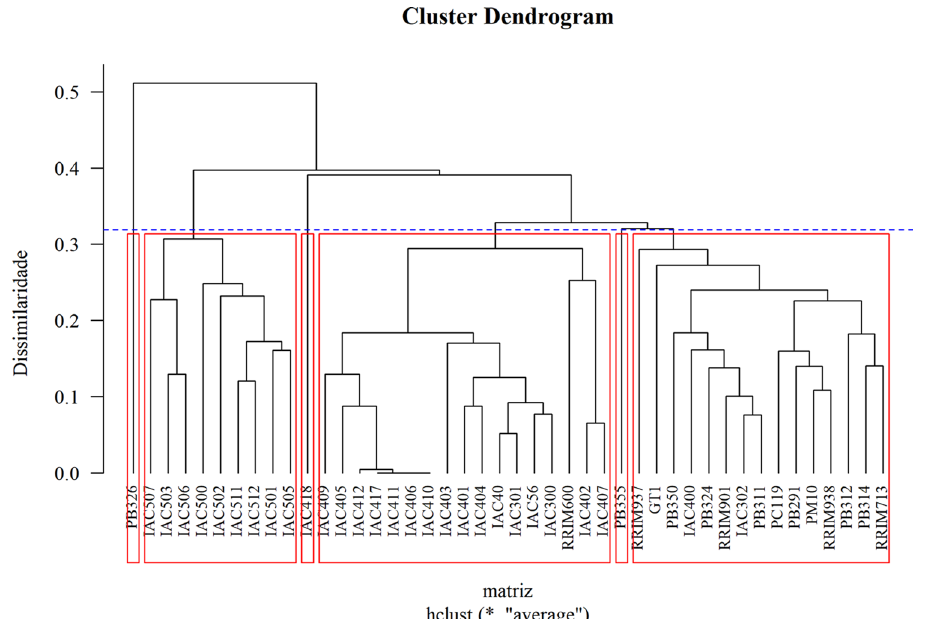
Figure 1. UPGMA cluster analysis of Euclidean distances based on data on the technological properties of natural rubber latex, used in the evaluation of the 44 rubber tree genotypes. The red line highlight the groups identified by K = 1.25; the cophenetic correlation was 0.77. From left to right: group I: PB 326; group II: IAC 500 series; group III: IAC 418; group IV: IAC 400 series, IAC 300, IAC 301, IAC 40, IAC 56 and RRIM600; group V: PB 355; group VI: Asiatic genotypes, IAC 400 and IAC 302. The percentage distance between cultivars is presented on the Y axis, and the 44 genotypes are presented on the X